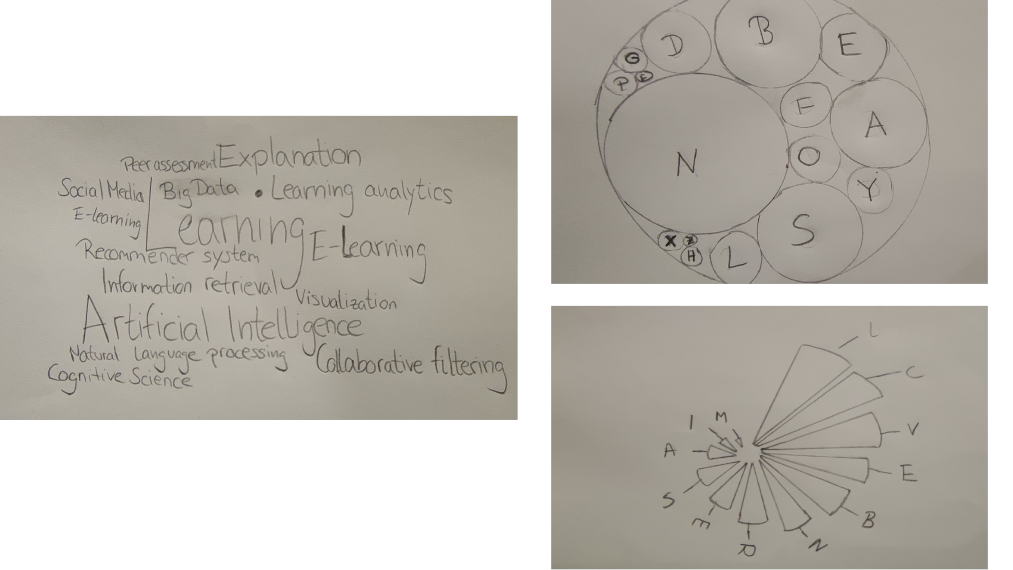
profile, the users were shown a view with a bar chart, buttons, and sliders (Figure 8).